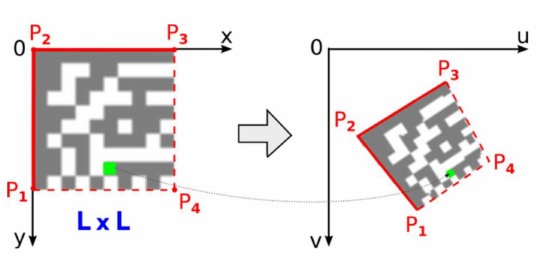
Figure 15. Perspective